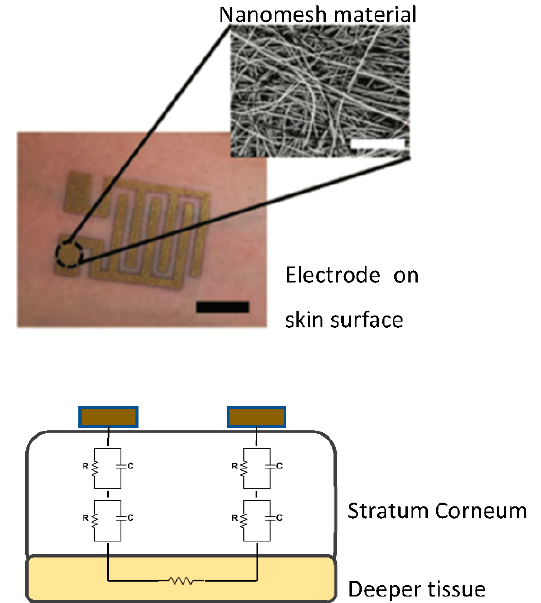
Figure 7. Measurement of skin impedance using nanomesh electrodes. Top : an optical photograph and SEM image of a nanomesh electrode pair attached to the skin. Bottom : the equivalent circuit of human skin. Modified from Matsukawa et al. [48].